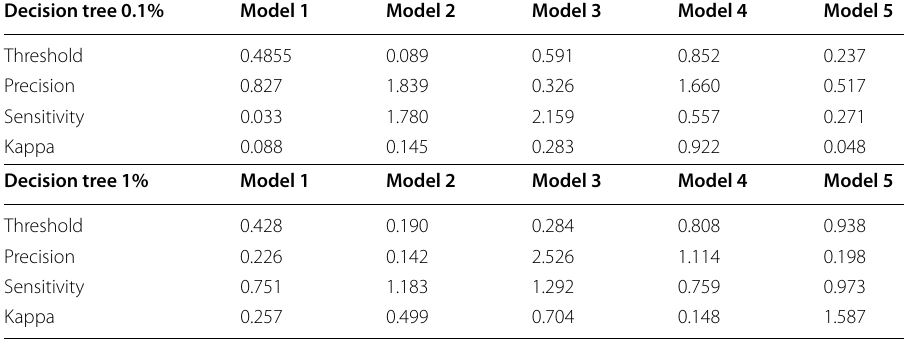
Table 3 Performance parameters, sensitivity, and precision of the decision trees Decision tree 0.1%